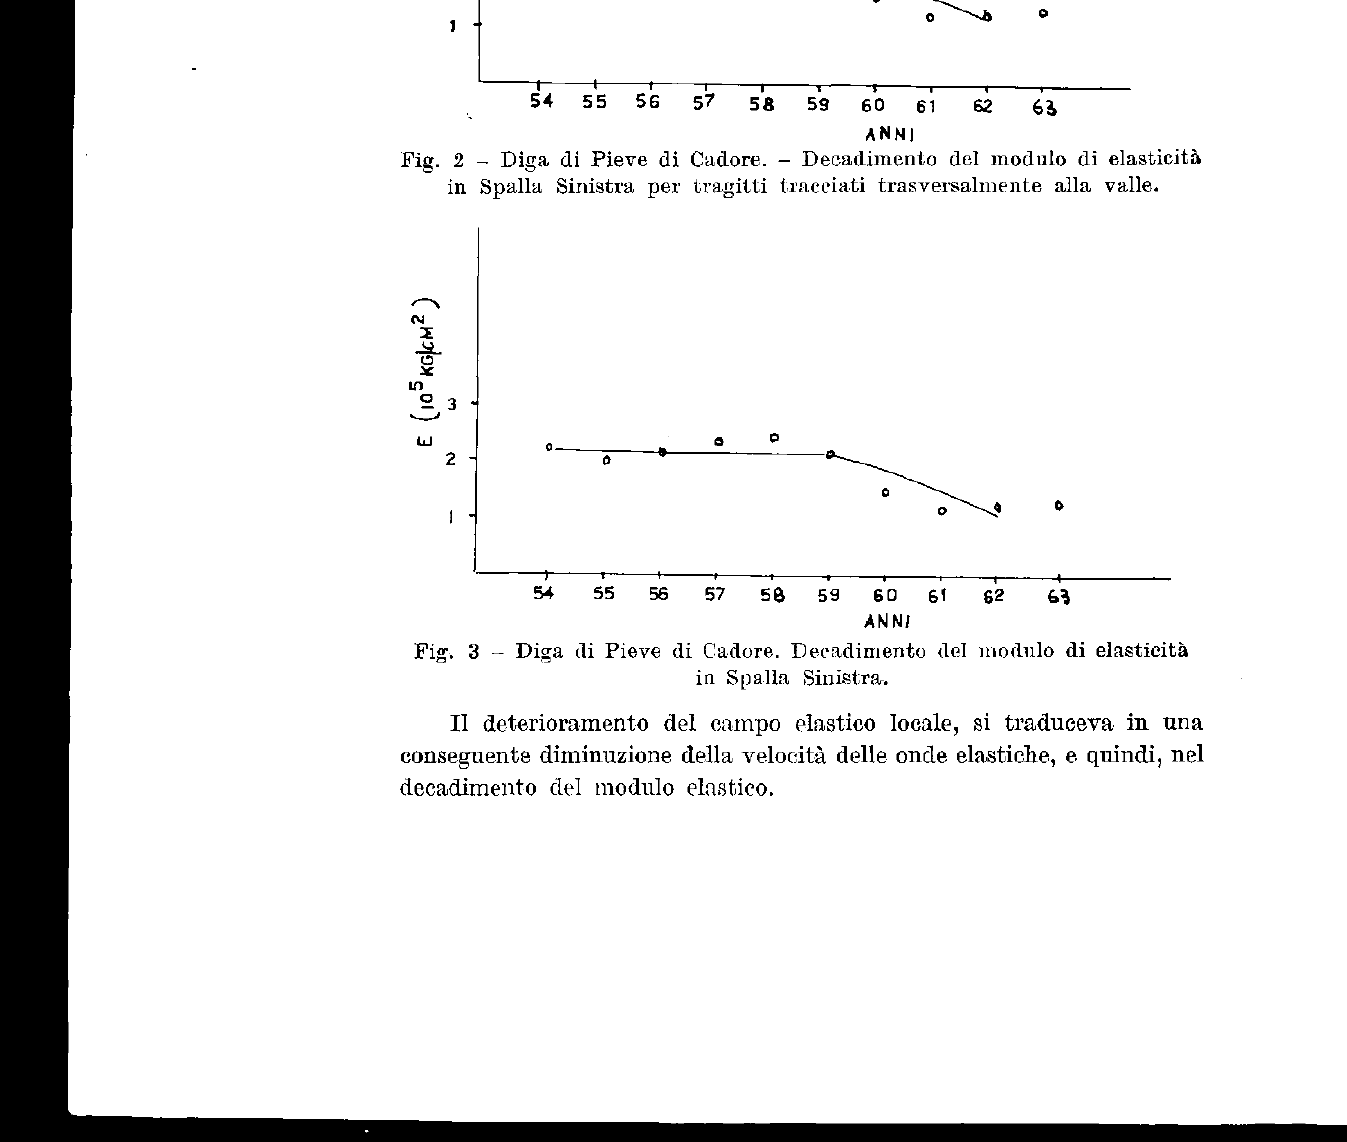
ANNI Fig. 2 - Diga di Pieve di Cadore. - Decadimento del modulo di elasticità in Spalla Sinistra per tragitti tracciati trasversalmente alla valle.